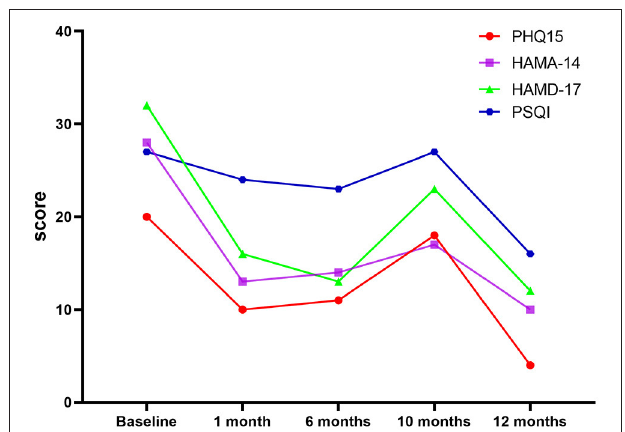
FIGURE 2 | Graph of PHQ15, HAMA-14, HAMD-17, and PSQI scores. PHQ-15, Health Questionnaire-15; HAMD-17, Hamilton Depression Scale-17; HAMA-14, Hamilton Anxiety Scale-14; PSQI, Pittsburgh Sleep Quality Index; WHOQOL-BREF, World Health Organization Quality of Life-Brief; SCL-90, Symptom Check List